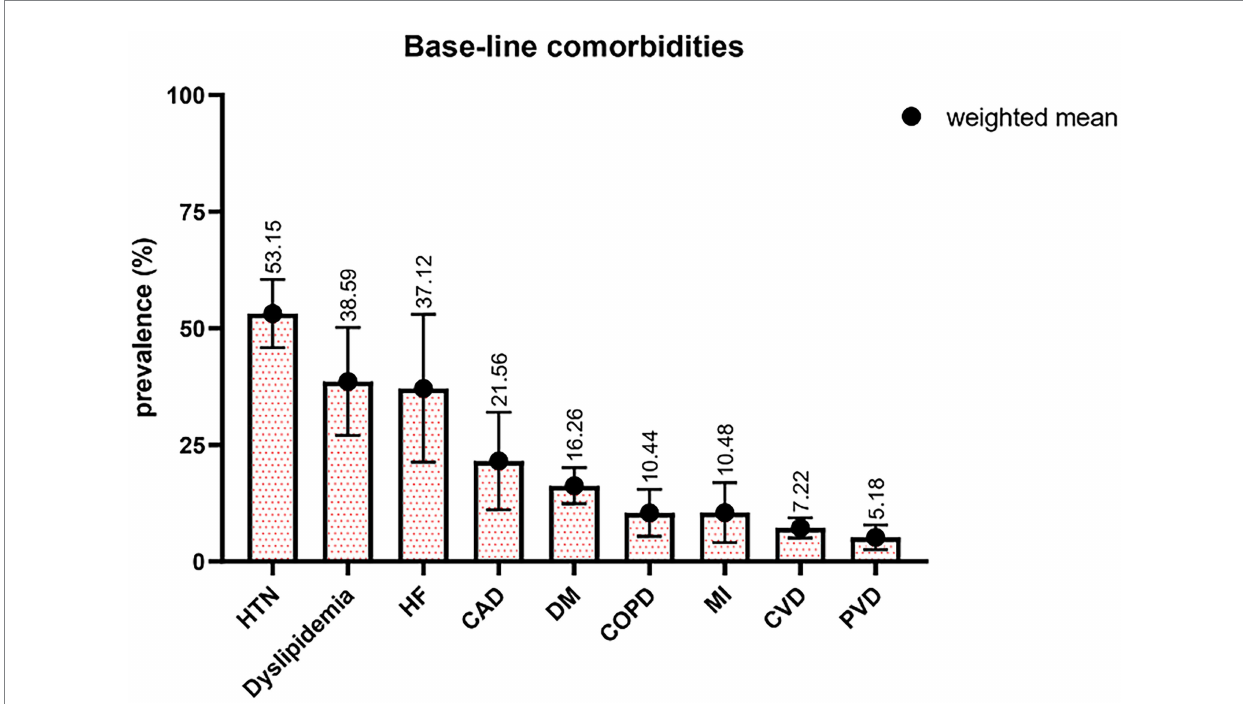
FIGURE 2 Percentages of patients with different comorbidities. HTN indicates hypertension; HF, heart failure; CAD, coronary artery disease; DM, diabetes mellitus; COPD, chronic obstructive pulmonary disease; MI, myocardial infarction; CVD, cerebrovascular disease; PVD, peripheral vascular disease.